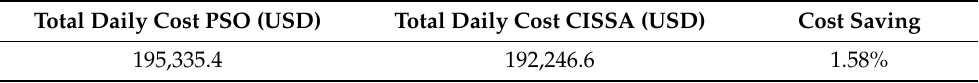
Table 10. Total daily cost comparison—case study